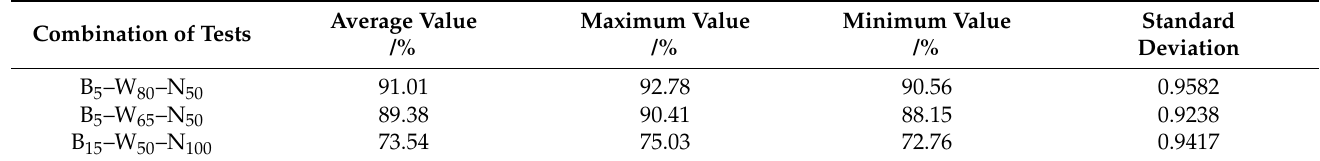
Table 3. Verification of the crushing resistance of the cucumber